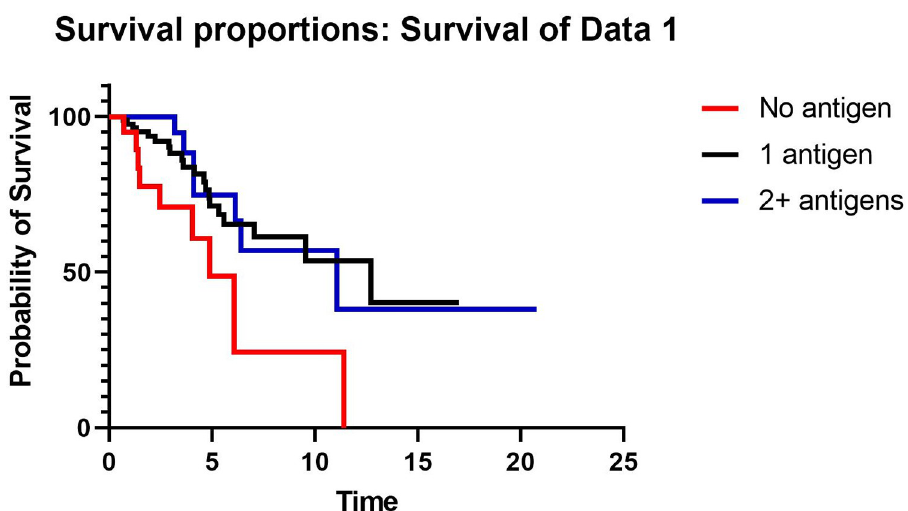
Fig 2. Kaplan-Meier curve comparing transplant-free survival in years in patients with no antigen identified, 1 antigen identified, or 2 or more antigens identified. https://doi.org/10.1371/journal.pone.0273544.g002 baseline PFTs were the same between groups. Patients with avian antigen exposure were more likely to undergo TBBx than patients with mold antigen, but among those who underwent TBBx the findings were not different between groups. The proportion of patients who under- went SLB and the probability of HP based on SLB results was similar between those with avian vs mold antigen.